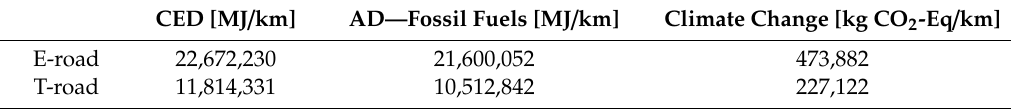
Table 16. The impacts of an e-road construction and maintenance for a lifetime of 20 years.